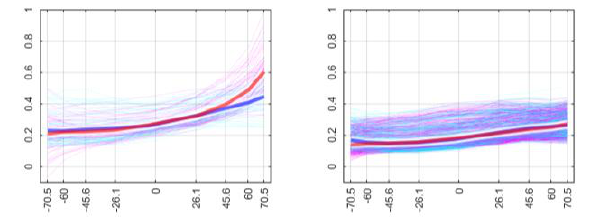
Figure 5. Comparison of accuracy of MCD43A1 model for snow pixels with that for the same pixels when free of snow